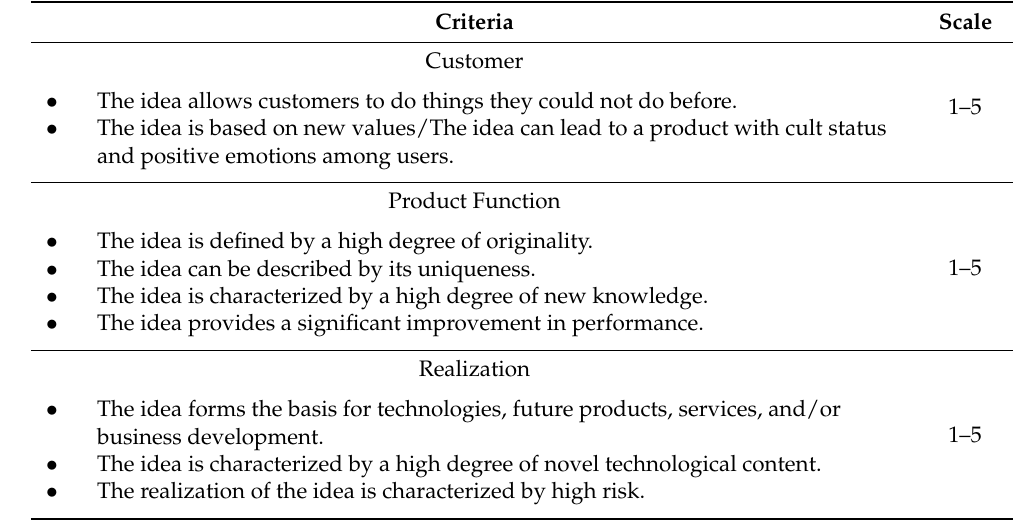
Table 3. Criteria to analyze the radicalness of product ideas, based on [33].